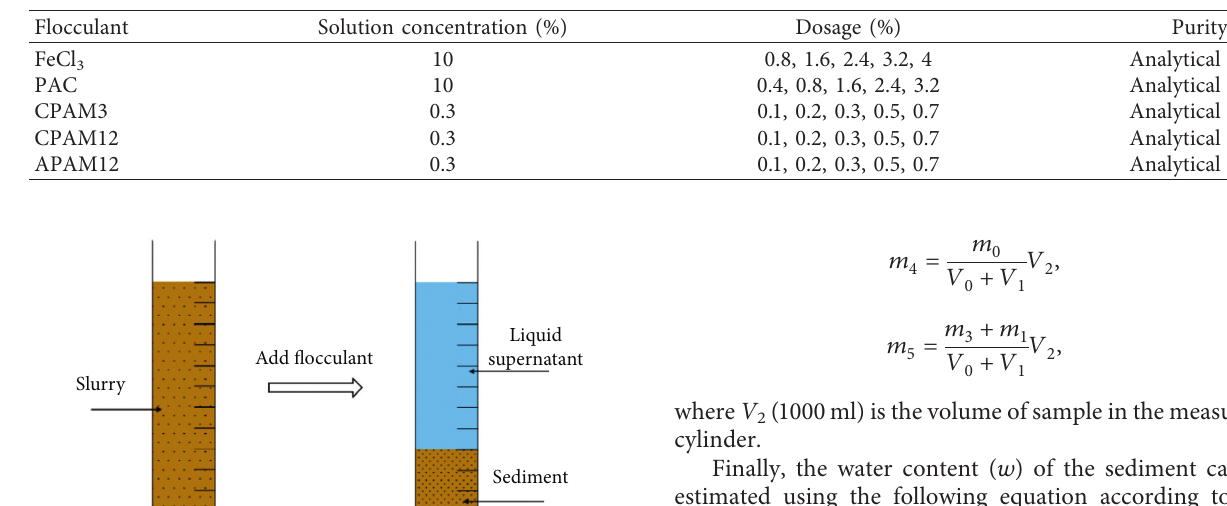
Figure 1: Grain size distribution of the slurry. Table 2: Flocculant types and dosage.